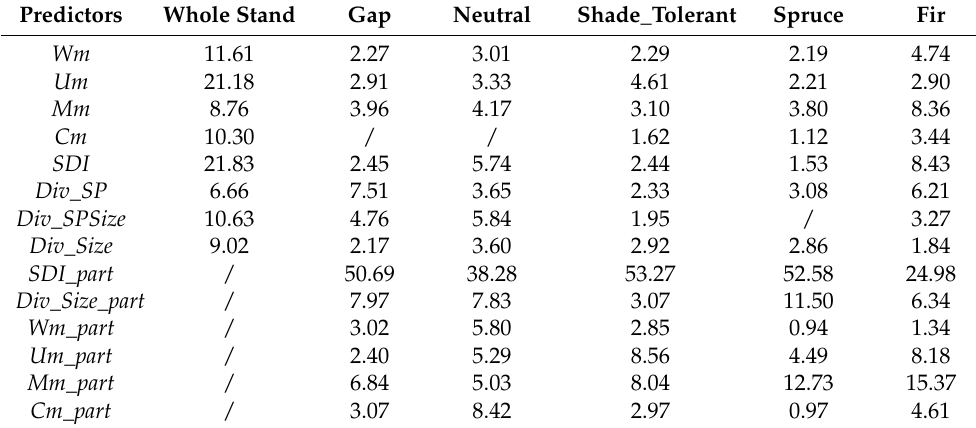
Table 5. The relative importance (%) of predictors for the six